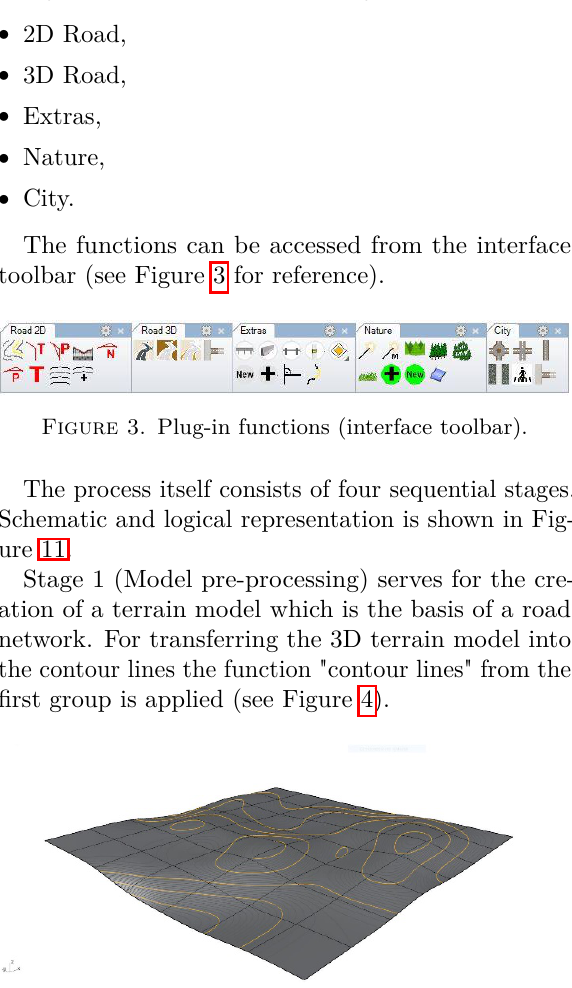
Figure 4. Terrain transfer to contour